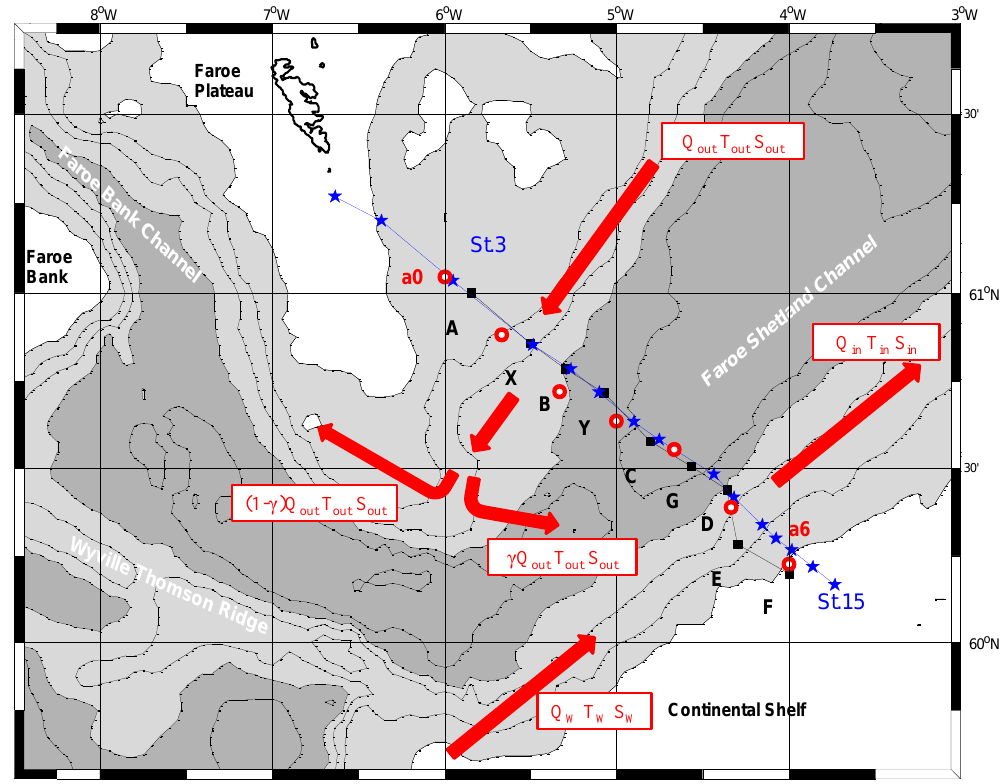
Fig. 2. Map of the Faroe–Shetland Channel with the locations of the observations. Stars show standard CTD stations (Fair Isle–Munken section) and squares show ADCP mooring locations. Red circles indicate altimetry grid points. The contour interval of the bottom topography is 200m; white areas are shallower than 200m; dark grey areas are deeper than 800m. For explanation about the arrows, please refer to Part 6.2 in the